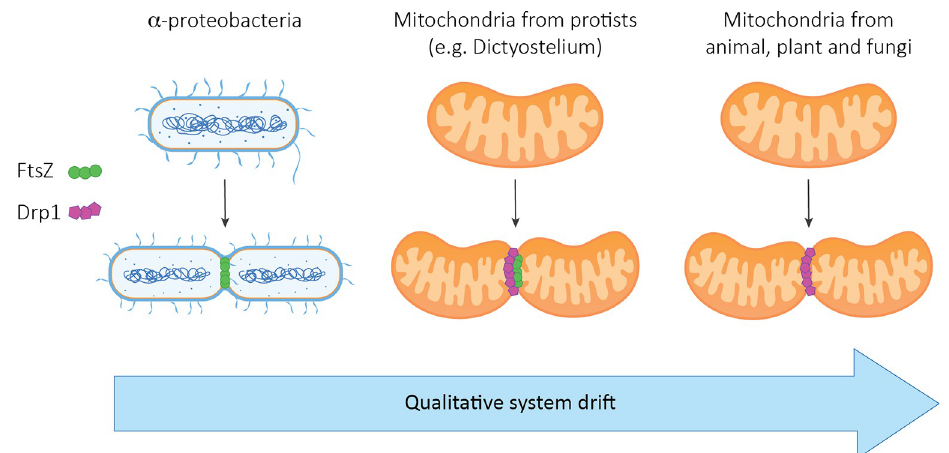
Fig 3. An example of qualitative system drift during binary fission. Mitochondria in the protist Dictyostelium , retain the bacterial protein FtsZ together with the eukaryotic Drp1, whereas in mitochondria in higher eukaryotes, only Drp1 is present, indicating a shift in the molecular effector for binary fission during